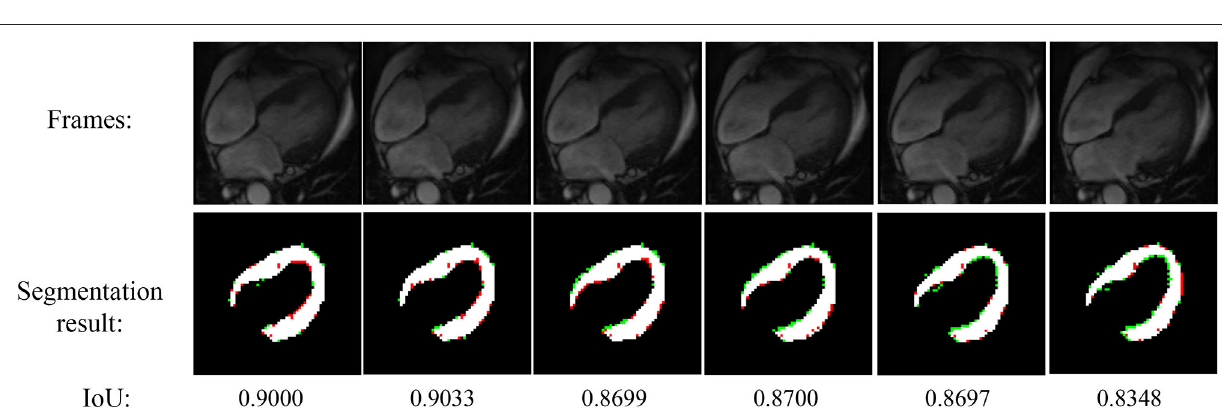
FIGURE 5 | Segmentation result of the proposed method during cardiac diastole.